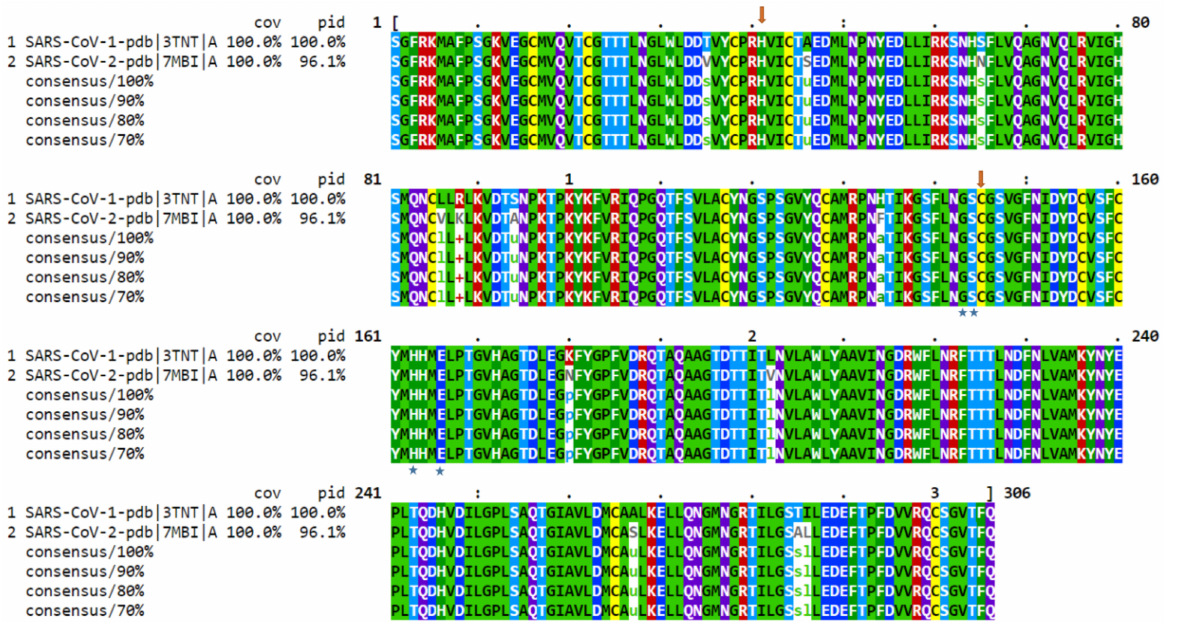
Figure 4. Multiple sequence alignment analysis of the amino acid sequence of SARS-CoV-1 and SARS-CoV-2 Mpro. Amino acids marked underneath with an arrow represent catalytic residues; residues marked underneath with * represent substrate- binding residues of various subsites.